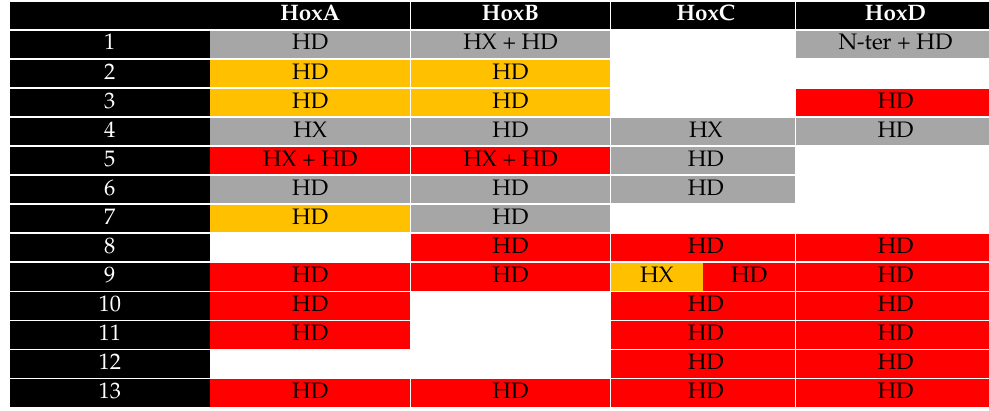
Table 1. Best score predictions for NLS sequences of human HOX proteins, generated by cNLS mapper [48]. (HX, hexapeptide; HD, homeodomain; Score: grey >3–5 ≥ ; orange >5–7 ≥ ; red > 7)).